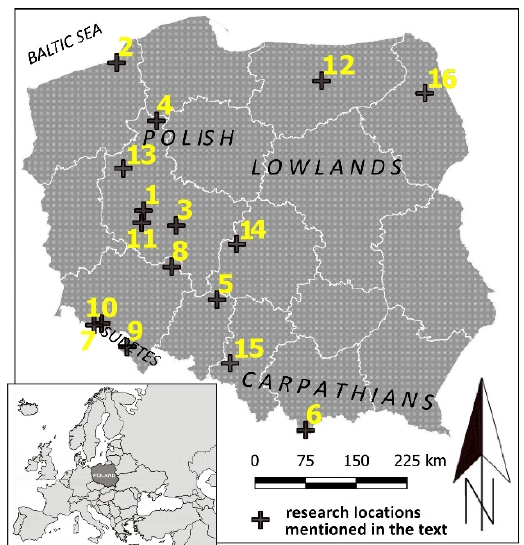
Figure 1. Map of Poland with locations of research areas mentioned in the paper: 1—Faculty of Forestry, Pozna ń University of Life Sciences; 2—Karnieszewice Forest District; 3—Jarocin Forest District and “Uroczysko Warta” floodplain forest; 4—Lipka Forest District; 5—Experimental Forest Unieszów; 6—Tatra Mountains National Park; 7—Karkonosze Mountains National Park; 8—Promotion Forest Complex of the Barycz River Valley; 9—Table Mountains National Park and K ł odzko Province; 10— Ś nie ż ka Forest District; 11—Greater Poland National Park; 12—Wipsowo Forest District; 13—Note ć Forest; 14—Jeziorsko reservoir; 15—Rudy Raciborskie Forest District; 16—Biebrza National Park.